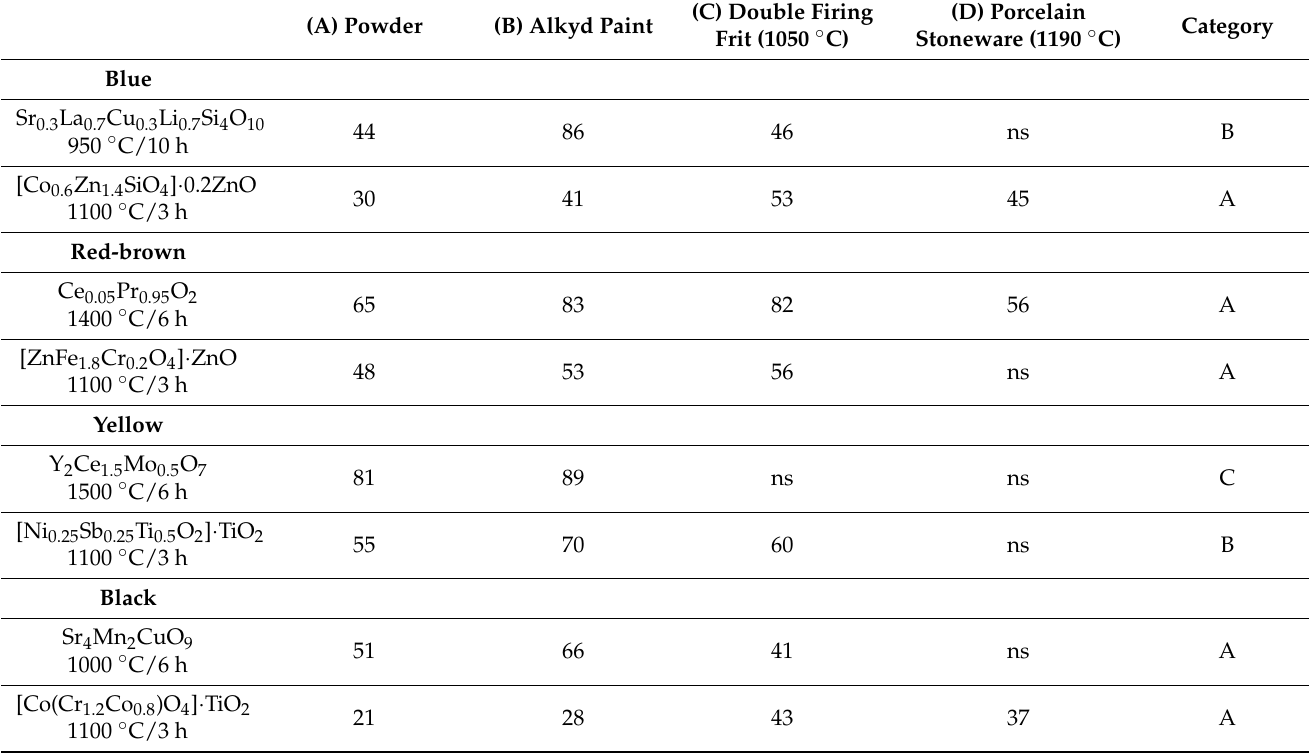
Table 7. R NIR (%) of the powder and its stable applications along with its Category (ns = no